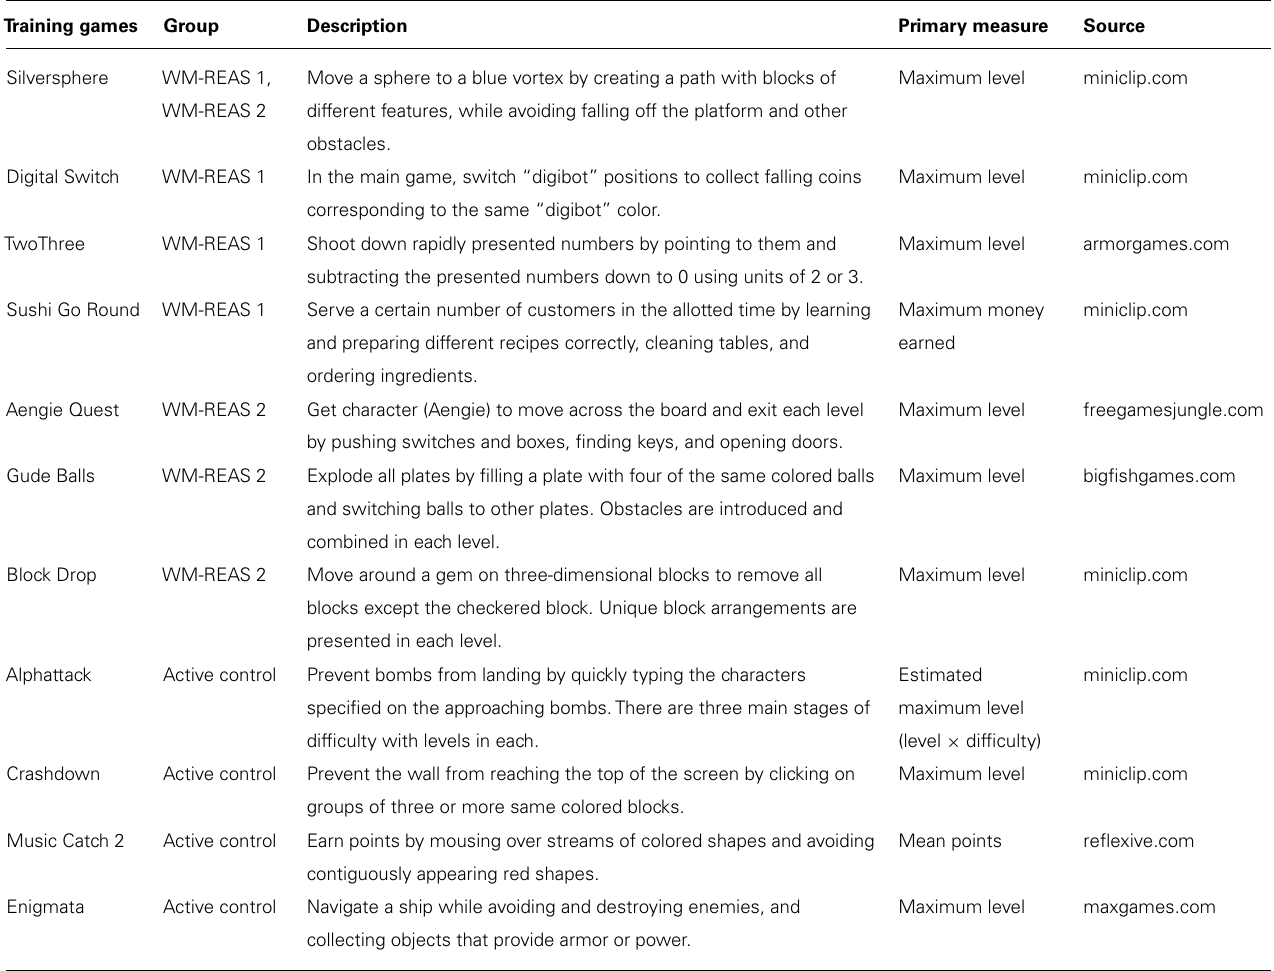
Table 3 |Training